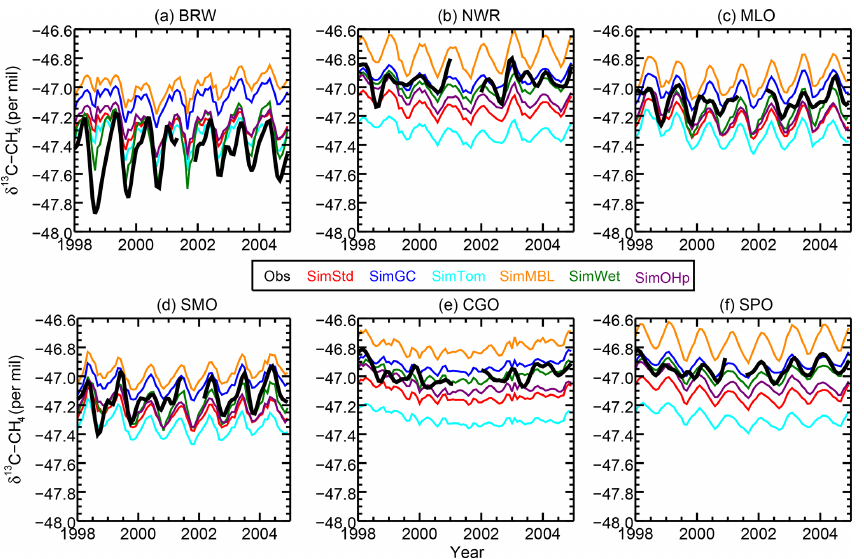
Figure 6. The time series of observed (black) and simulated (colors) δ 13 CH 4 at the six GMD sites with records extending back to 1998. BRW: 71.3 ◦ N, 156.6 ◦ W; NWR: 40.0 ◦ N, 105.6 ◦ W; MLO: 19.5 ◦ N, 155.6 ◦ W; CGO: 40.7 ◦ S, 144.7 ◦ E; and SPO: 90.0 ◦ S, 24.8 ◦ W.